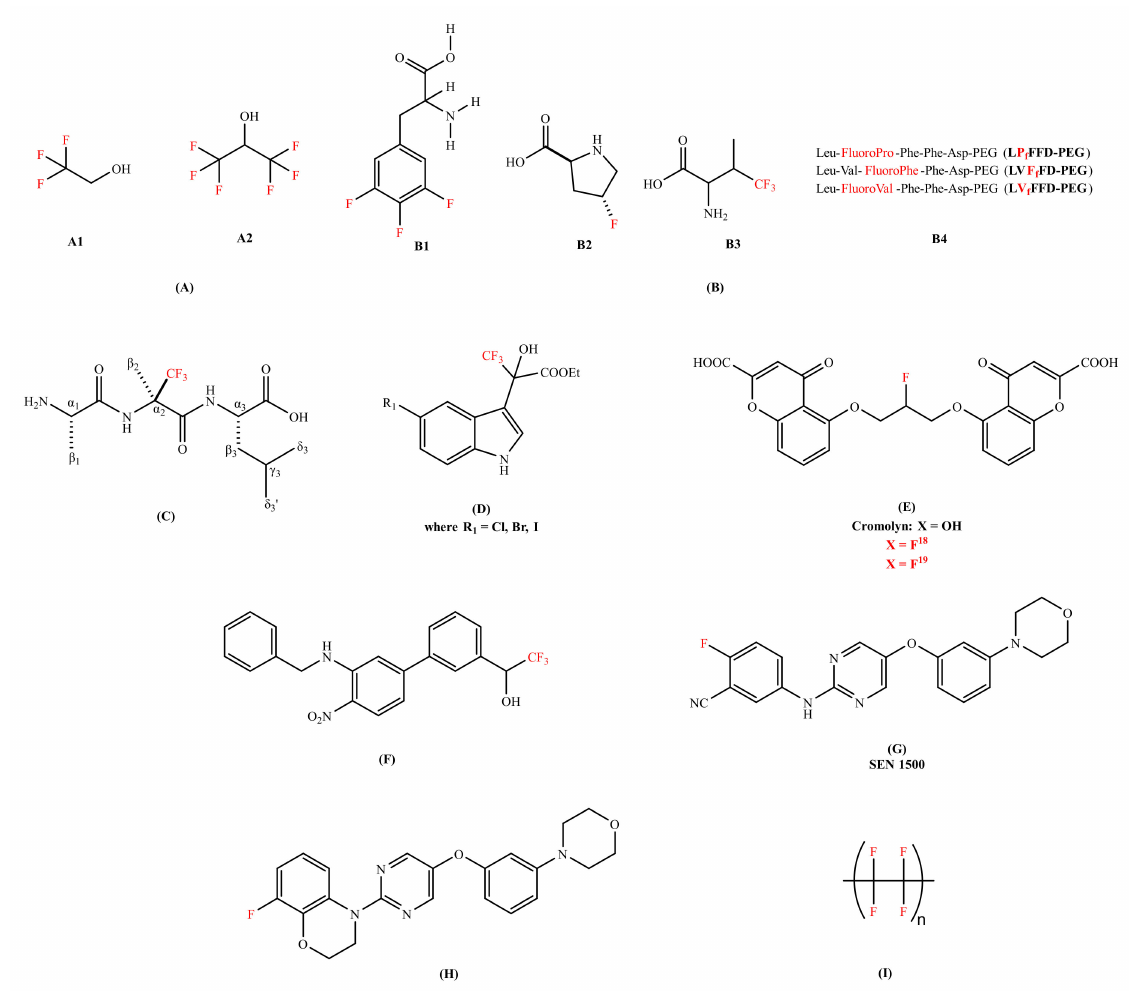
Figure 2. Chemical structures of the fluorine-containing compounds for the inhibition of amyloid-beta peptide. ( A ) Fluorinated alcohols (A1: 2,2,2-trifluoroethan-1-ol (TFE), A2: 1,1,1,3,3,3-hexafluoropro pan-2-ol (HFIP));. ( B ) Fluorinated amino acids and peptides (B1-3,4,5-trifluorophenylalanine, B2- 4-fluoroproline, B3- 4,4,4-trifluorovaline, B4- Fluorinated peptides conjugated to Polyethylene glycol (PEG)); ( C ) (R)- α -trifluoromethylalanine peptide (H-Ala-(R)-Tfm-Ala-Leu-OH); ( D ) Trifluoro-hydroxylindolyl-propionic acid esters;. ( E ) Cromoyln-based derivative (5,5’-((2-fluoropro pane-1,3-diyl)bis(oxy))bis(4-oxo-4H-chromene-2-carboxylic acid)); ( F ) Organofluorine inhibitor (1-(3’-(benzylamino)-4’-nitro-[1,1’-biphenyl]-3-yl)-2,2,2-trifluoroethan-1-ol);.( G ) SEN1500 (2-fluoro-5-((5-(3-morpholinophenoxy)pyrimidin-2-yl)amino)benzonitrile); ( H ) 8-fl uoro-3,4-dihydro-2H benzo [1,4] oxazine inhibitor (8-fluoro-4-(5-(3-morpholinophenoxy) pyrimidin-2-yl)-3,4-dihydro-2H-benzo[b][1,4]oxazine); and ( I )